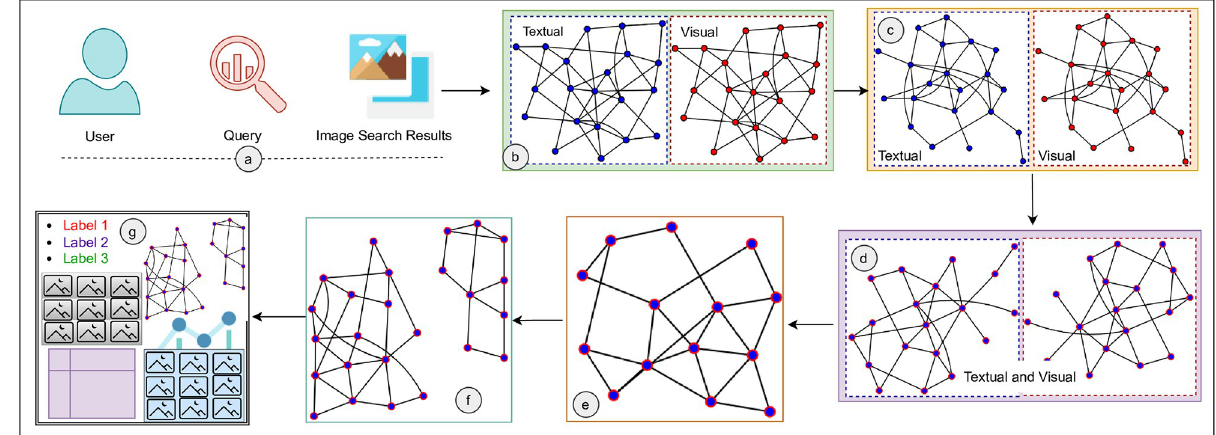
Fig 3. Schematic representation of approach architecture depicting; Image results retrieval (a), Dense and complex graphs (b), Simplified image graphs (c), Converted image similarity graphs (d), Multimodal image tree (e), Image forest (f), and Exploration components (g).